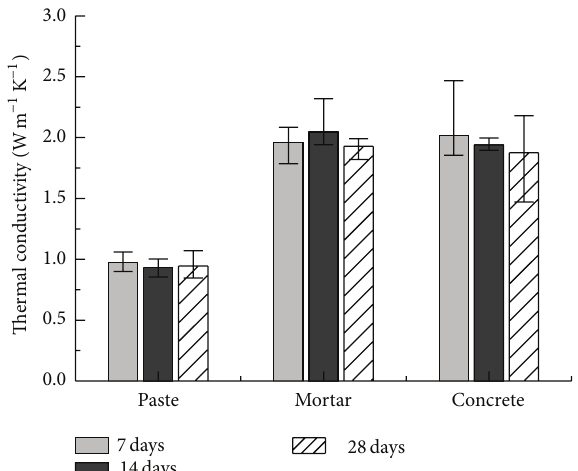
Figure 5: Effect of fine and coarse aggregates.